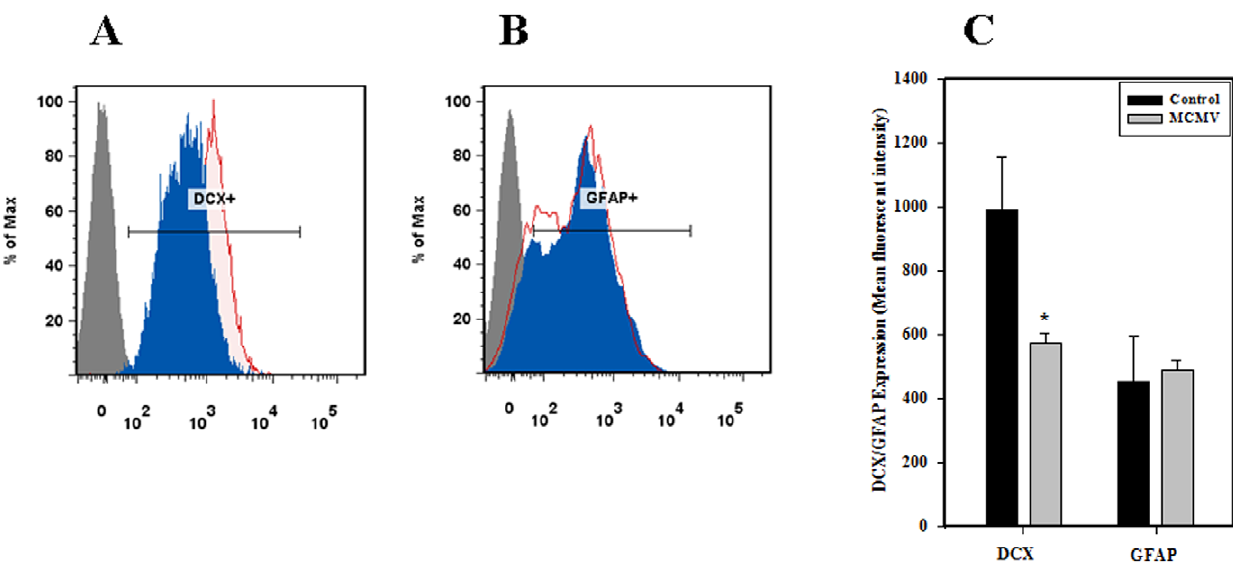
Figure 7. Decreased expression of DCX in the infected brain. Cells isolated from MCMV-infected and control brains were analyzed for intracellular doublecortin (DCX) and glial fibrillary acidic protein (GFAP) at 7 d p.i. Histogram overlays from isotype (grey line, filled), infected (blue line, filled), and control (red line, tinge) are shown for: A . DCX, a marker for young/immature neurons and B . GFAP, a marker for glial precursors. Infected brains showed reduced expression levels of intracellular DCX compared to control brains while there was no difference in the expression levels of GFAP in MCMV infected versus control brains. C . Data were derived from 3 independent experiments, n=3–5 neonates. * p , 0.05 versus mock infected.